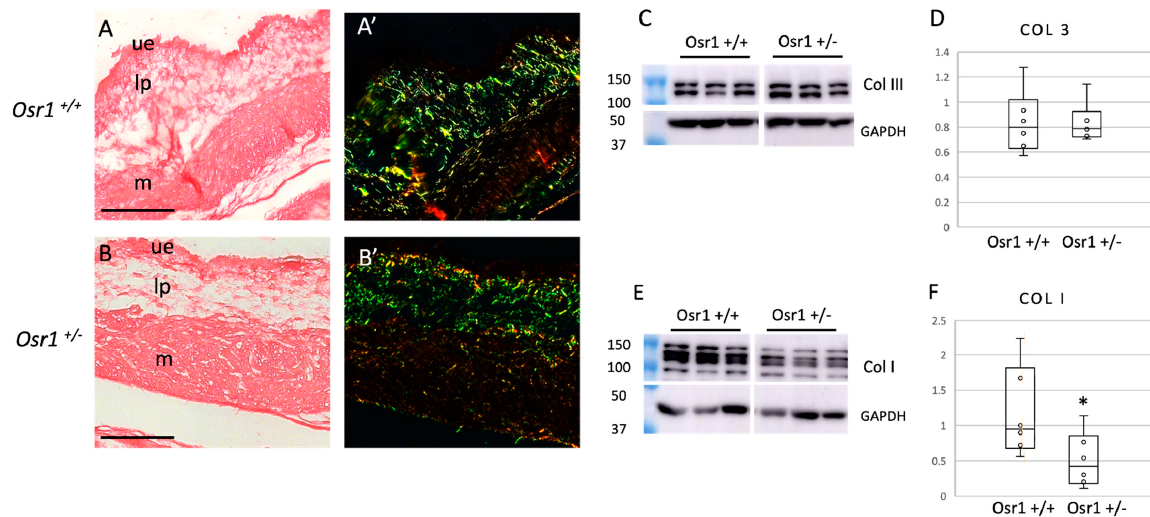
Figure 4. Osr1 +/ − newborn mouse bladders have decreased collagen I: Sirius red staining of Osr1 +/+ ( A , A’ ) and Osr1 +/ − ( B , B’ ) mice at the newborn stage show a decrease in collagen in Osr1 +/ − mice. Under a polarized light filter ( A’ , B’ ) a decrease in thick (yellow) fibers is seen in the bladders of Osr1 +/ − mice. Western blots of whole bladder lysates ( C , E ) show a decrease in total levels of Collagen I but not Collagen III in Osr1 +/ − mice. Quantitative analysis ( D , F ) shows collagen normalized to GAPDH protein levels. There is a statistically significant decrease in Col I protein expression in Osr1 +/ − mice, asterisk (*) indicates p = 0.05. n = 6 bladders/genotype. Scale bars = 100 m. ue = uroepithelial layer, lp = lamina propria, m = muscle.